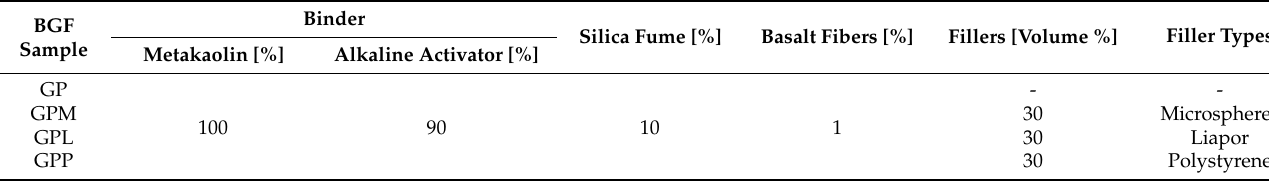
Table 1. Mixing proportions of the geopolymer